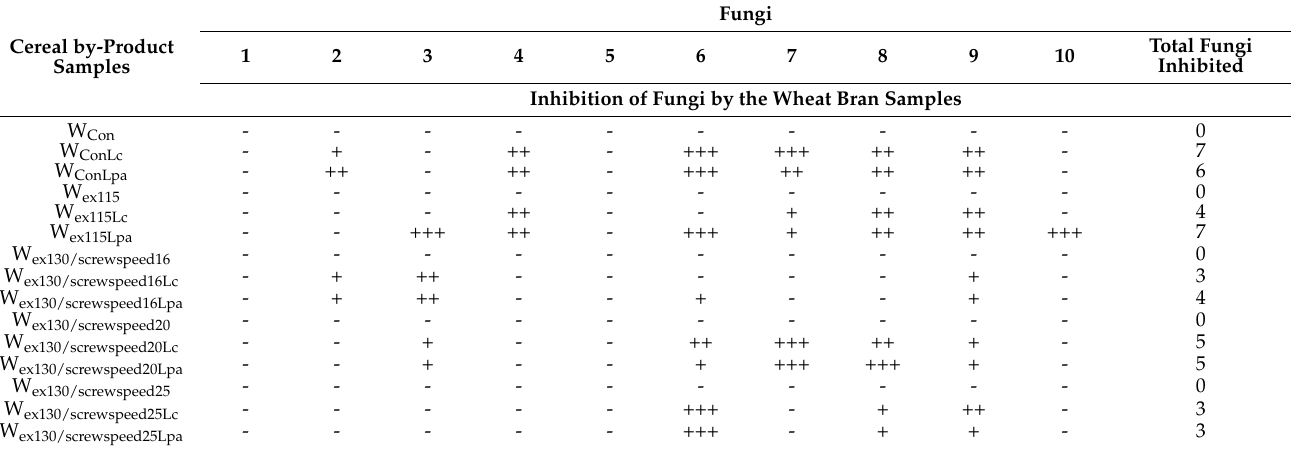
Table 3. Antifungal properties of extruded and non-treated wheat processing by-products, non- fermented and fermented with L. casei and L. paracasei